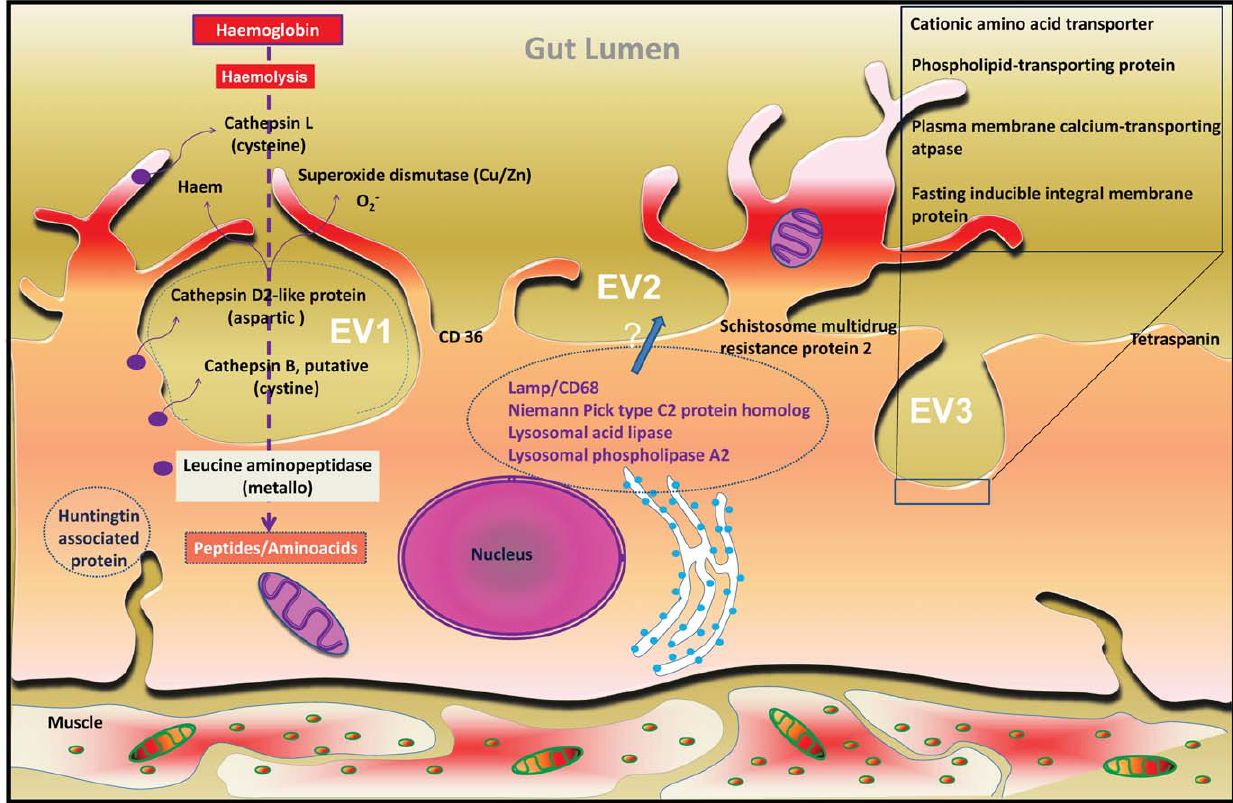
Figure 3. Diagrammatic representation of the gastrodermis of female S.mansoni . The diagram is based on an illustration originally published by Morris [52]. The illustration shows some highly enriched genes identified in this transcriptomic survey (Table 1, Table S3). Many of the genes products are putatively released into, or onto the membrane of epicellular vacuoles (EV) present at the luminal surface of the syncytial epithelium. Three EVs are depicted (EV1–3), each showing different physiological activities proposed to occur in the vacuoles. EV1 depicts haemoglobinolysis pathways. Many proteases are released into the EV, resulting in catabolism of haemoglobin into amino acids or small peptides for uptake. Haem, a byproduct of catabolism, is sequestered into haematin (see illustration in [53]) for subsequent egestion. EV2 depicts a potential series of molecules associated with lysosomal functions, which has been transferred to these vacuolar compartments. EV3 shows a series of membrane proteins, involved in a variety of functions, notably transmembrane transport of metabolites, which would be preferentially associated with the epicellular vacuoles. All three physiological activities may occur in the same vacuole, probably concurrently.